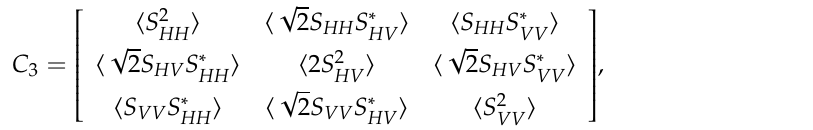
Figure 3. Polarized parameters extraction. We extracted 13 polarized parameters in total. They are